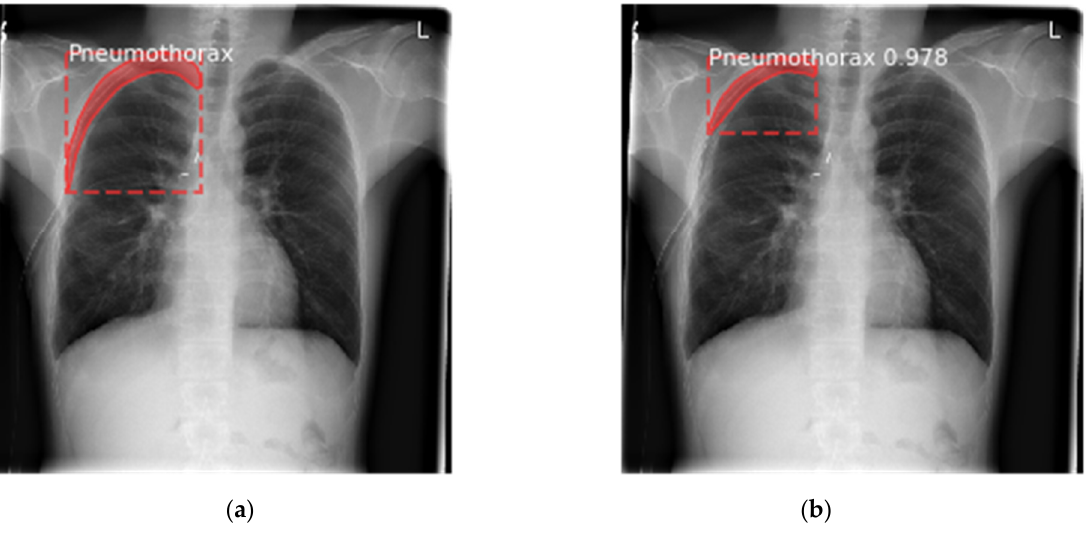
Figure 13. Sample validation dataset image with different annotations predicted by the proposed model,( a ) annotations on ground truth image;( b ) annotations predicted by proposed model.